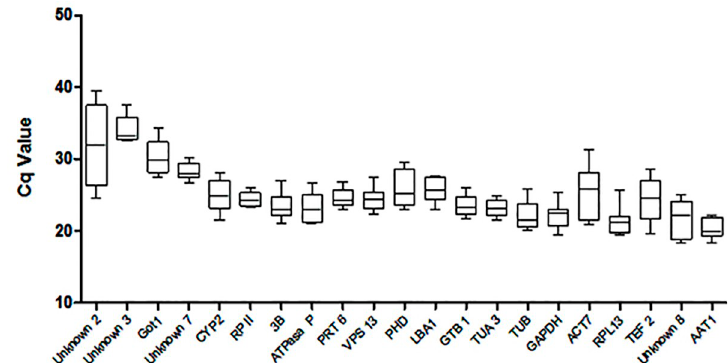
Fig 1. Expression levels of different candidate housekeeping genes for Prunus spp. Expression data displayed as RT -qPCR quantification cycle (Cq) values for the housekeeping genes in Prunus spp. under hypoxia. The line across the box depicts the median. The box indicates the 25th and 75th percentiles, and whisker caps represent the maximum and minimum values.